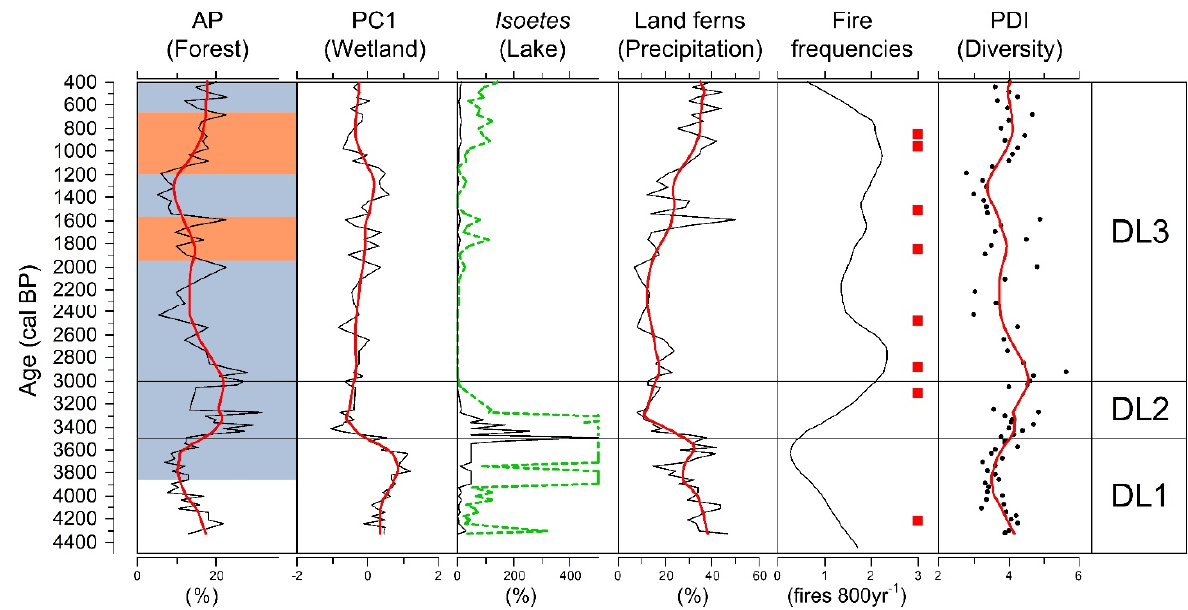
Figure 8. Summary of the paleotemperature (arboreal pollen, AP), wetland area (PC1), water area ( Isoetes ), precipitation (land ferns), fire frequency, and floristic diversity (PDI) of Dream Lake, as inferred from sedimentary proxies, over the last 4500 cal BP. Fire peaks are indicated with red squares. The red lines are smoothed curves generated using the locally weighted scatterplot smoothing method in C2 ver. 1.5 for Windows. The green dashed line is a 10-fold exaggeration of the original values. The background of the AP column indicates the late Holocene climatic conditions in Taiwan (red = warm period; blue = cold period), based on a summary of four palynological records [32].